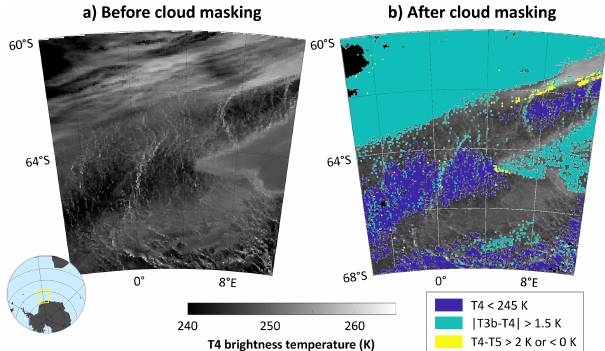
Figure 1. Infrared brightness temperature T4 from APP (provided by NOAA, Key et al., 2019) on 13 August 2009 before (a) and after (b) cloud masking. Colours indicate the different masking criteria on T4 (Yamanouchi et al., 1987, indigo), T34 (as detailed in Ap- pendix A, modified from Yamanouchi et al., 1987, green), and T45 (Vincent et al., 2008; Vincent, 2018, yellow). The insert indicates the location of the two